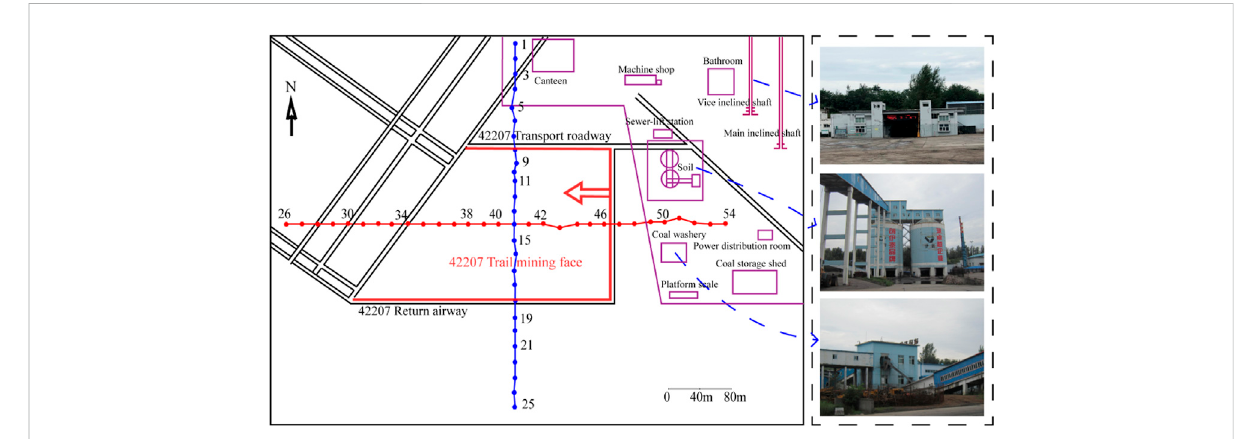
FIGURE 8 Layout of the surface subsidence measurement points and distribution of surface features.